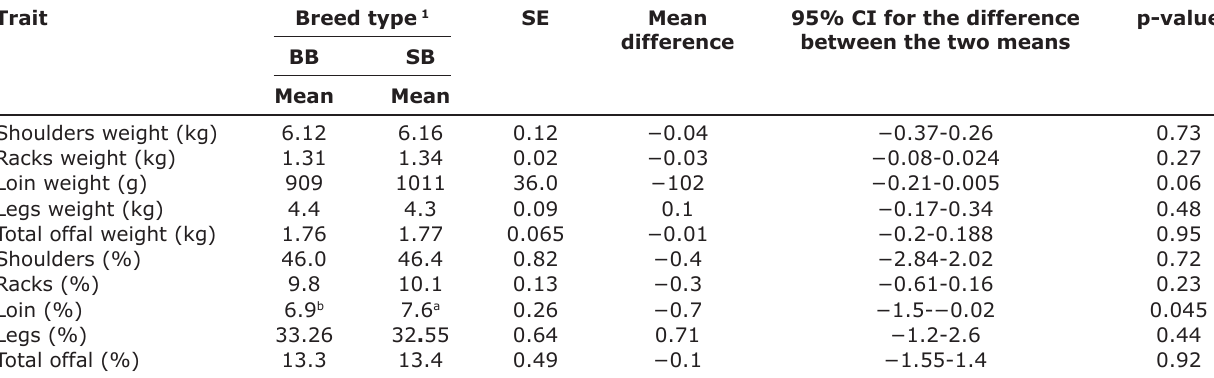
Table-2: Means, SE, and 95% CI for the difference between the means for carcass cut weight and percentage in BB and SB kids.